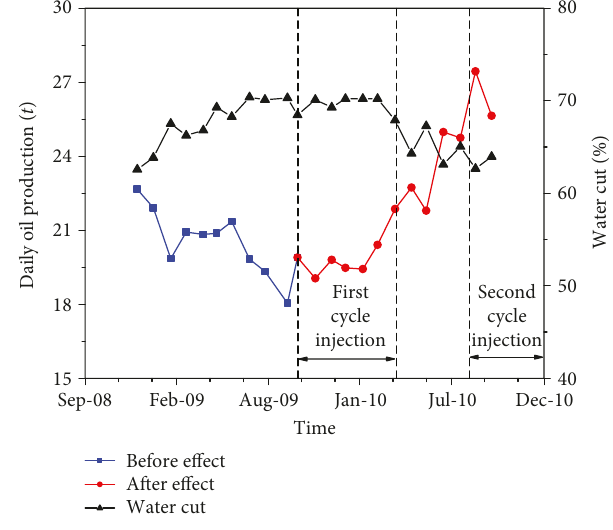
Figure 11: Chao 50 MFR fi eld test production performance [54]. Figure 12: Chao 50 expansion MRF fi eld test production performance